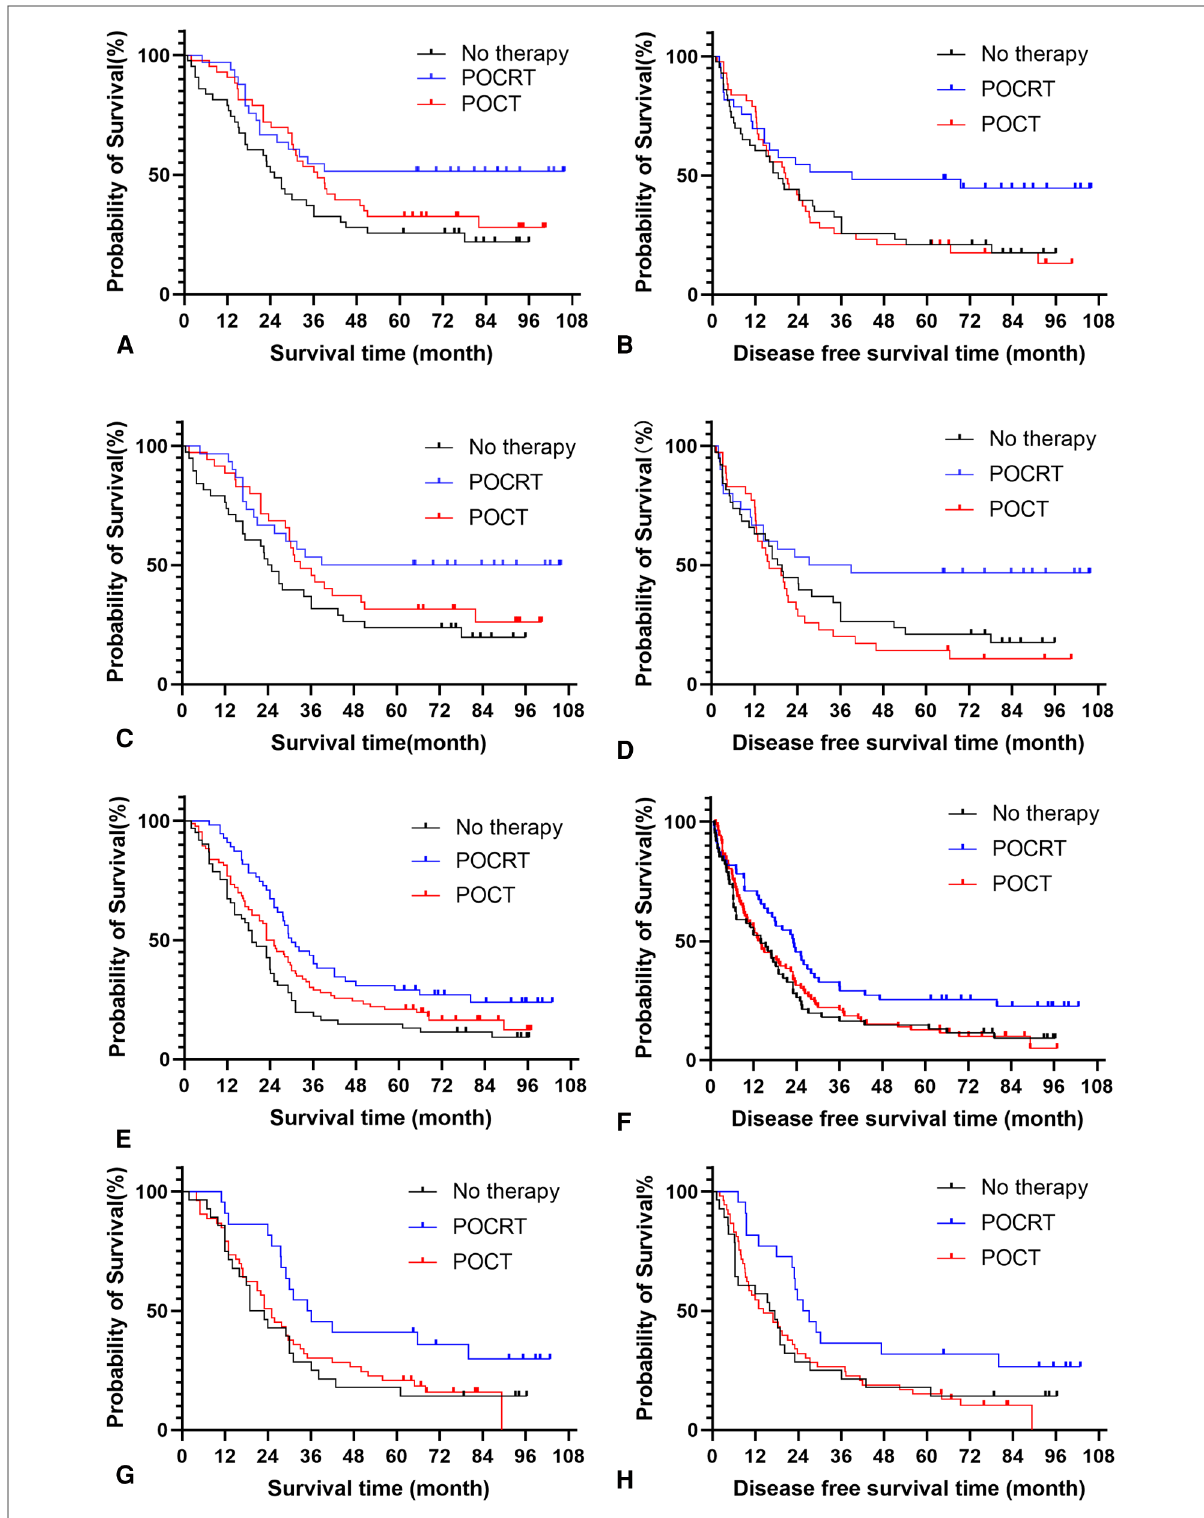
FIGURE 3 Analysis of postoperative adjuvant treatment modes for patients with different sites of metastatic nodes before and after propensity score matching. ( A ) Survival analysis of NSM patients before propensity score matching. ( B ) Disease free survival analysis of NSM patients before propensity score matching. ( C ) Survival analysis of NSM patients after propensity score matching. ( D ) Disease free survival analysis of NSM patients after propensity score matching. ( E ) Survival analysis of NNSM patients before propensity score matching. ( F ) Disease free survival analysis of NNSM patients before propensity score matching. ( G ) Survival analysis of NNSM patients after propensity score matching. ( H ) Disease free survival analysis of NNSM patients after propensity score matching. Note: NSM: nodal skip metastasis; NNSM: no-nodal skip metastasis; PORT: postoperative radiotherapy; POCT: postoperative chemotherapy; POCRT: postoperative radiotherapy and